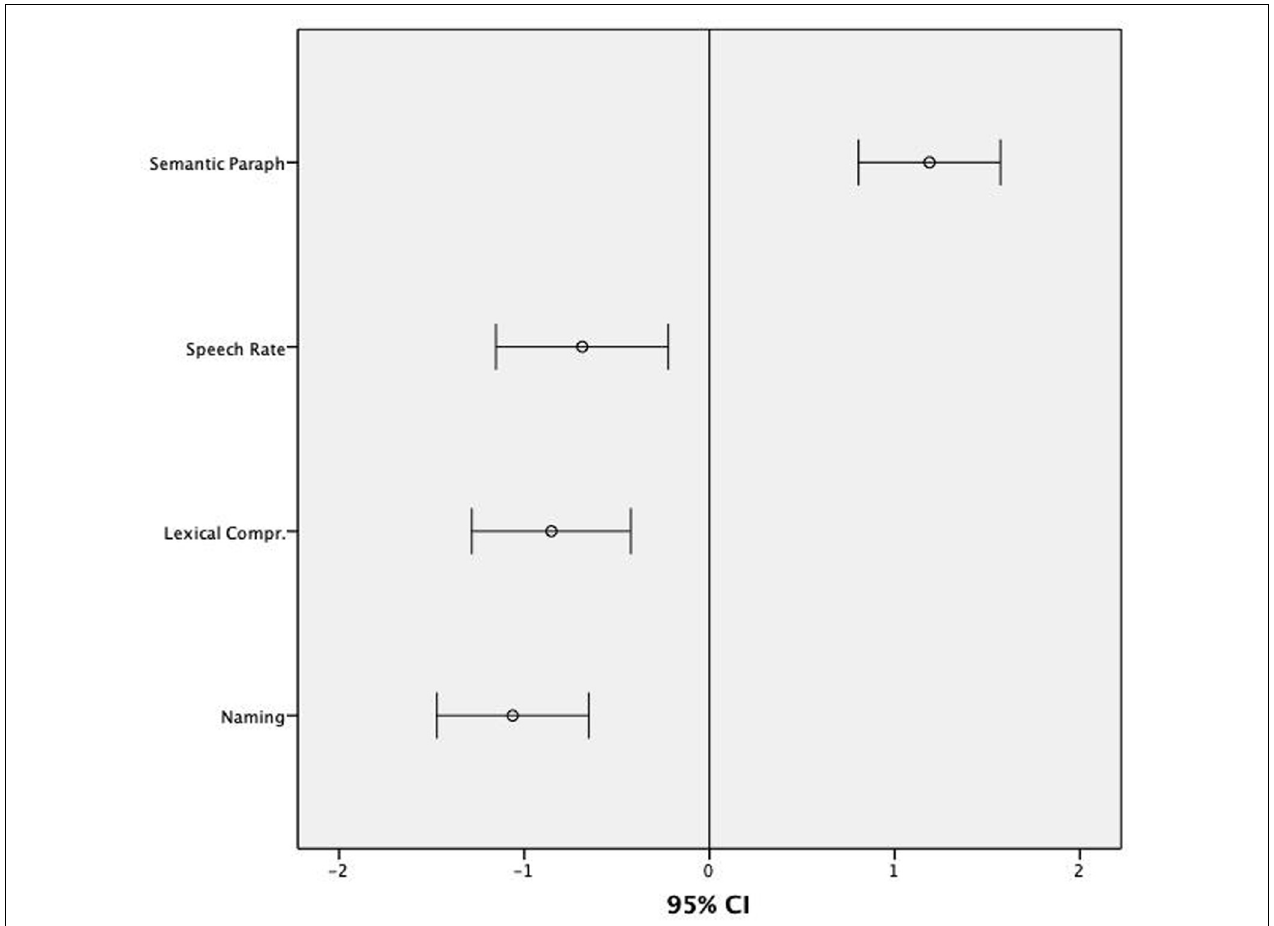
FIGURE 1 | Mean z-scores and 95% CIs for the scores assessing lexical skills in children with ASD in relation to normative data.